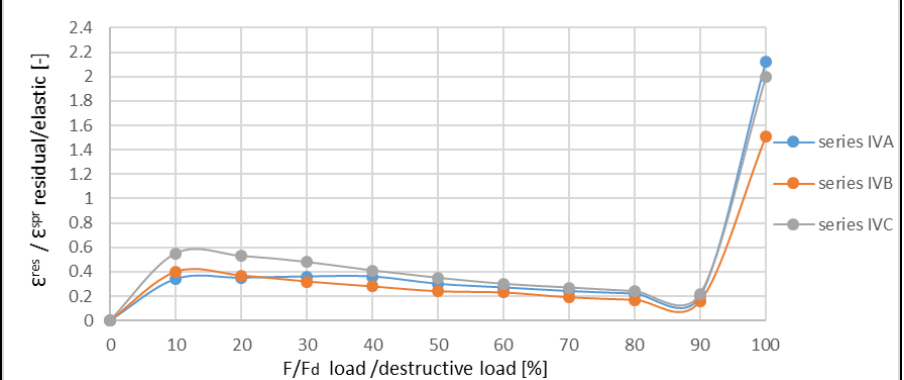
Figure 15. Example graph showing the ratio between residual and elastic strains regarding the ratio between the applied load and destructive load (beams of IV-th series).